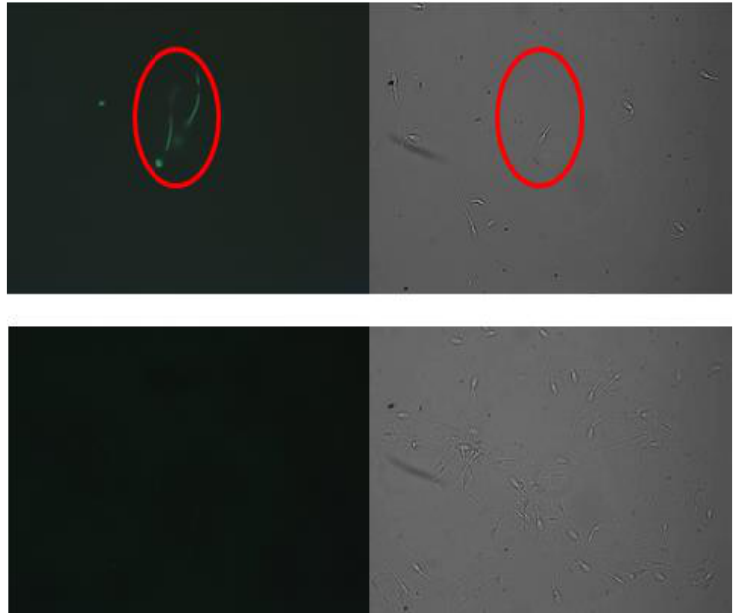
Figure 4. Fluorescent (left panel) and visible light (right panel) of the same microscopic field (200× magnification). The images show that blocking with BSA for as little as 10 min before the addition of biot-BSA did not inhibit biot-LF/SOD-3 binding ( upper panel ) but resulted in the inhibition of biot-BSA binding to sperm ( lower panel ) indicating the specificity of LF to its receptors. The red circle identifies the same spermatozoa.